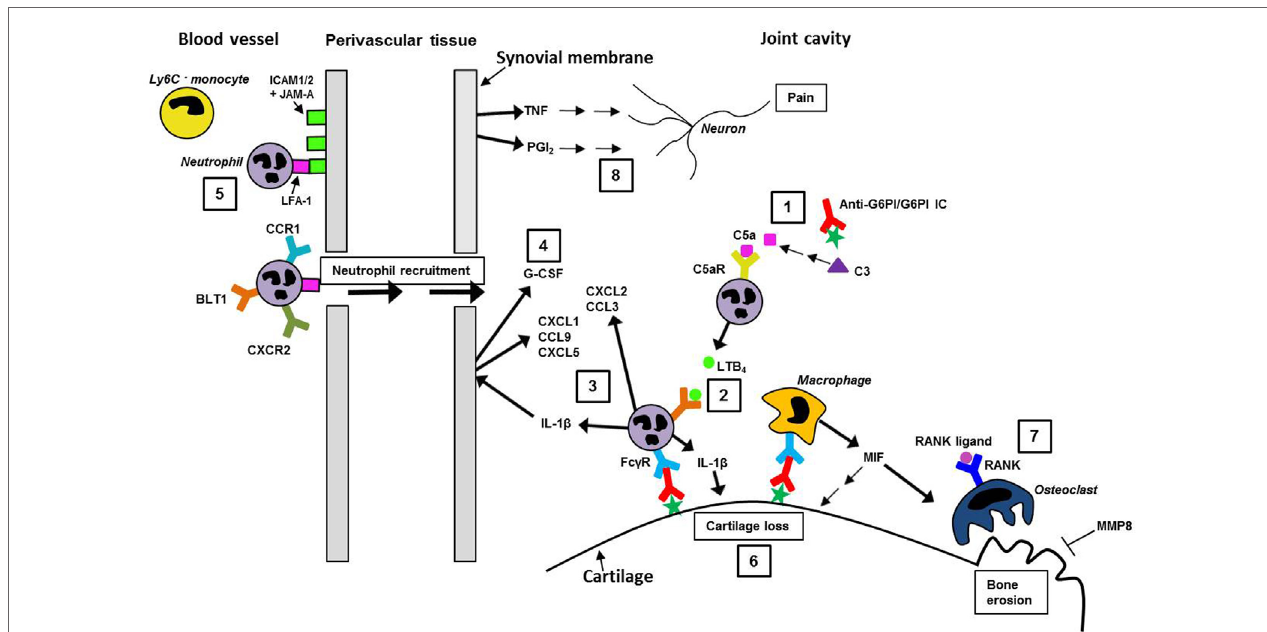
FiGURe 2 | The “effector phase” of the K/BxN STA model . A summary of some of the literature on the subsequent stages of K/BxN STA progression, driven by joint-localized anti-G6PI/G6PI ICs and their proposed interaction with innate immune cells, such as neutrophils and macrophages, is depicted. (1) The alternative complement pathway is activated by the ICs, leading to C3 cleavage and eventually to the generation of C5a. Subsequently, C5a activates neutrophils via C5aR, which leads to their release of LTB 4 . (2) Activation of neutrophils by the LTB 4 /BLT1 interaction and (3) by Fc γ -receptors (Fc γ Rs) leads to the release of interleukin 1 β (IL-1 β ), which then induces neutrophil-attracting chemokines, for example, CXCL1, CXCL5, and CCL9, from resident tissue cells. Additionally, neutrophils participate in their own recruitment by releasing the chemokine CXCL2 (CXCR2 ligand) and to a lesser extent, CCL3 (CCR1 ligand). (4) IL-1 β , and other pro-inflammatory cytokines, mediates the release of G-CSF locally in the joint, leading to neutrophil mobilization. (5) Leukocyte, for example, neutrophil, recruitment into the joint is facilitated by their LFA-1 binding to its ligands (ICAM1, ICAM2, and JAM-A) expressed on the activated vascular endothelium; Ly6C − blood monocytes are also recruited (not shown). (6) Cartilage loss in the inflamed joint is mediated by, for example, IL-1 β and macrophage-derived macrophage migration inhibitory factor (MIF). (7) Bone erosion upon osteoclast activation by RANK ligand/RANK interaction and release of MIF; MMP8 can protect against bone erosion and arthritis. (8) Both TNF and the prostaglandin, PGI 2 , are produced in the joint and either directly or indirectly mediate